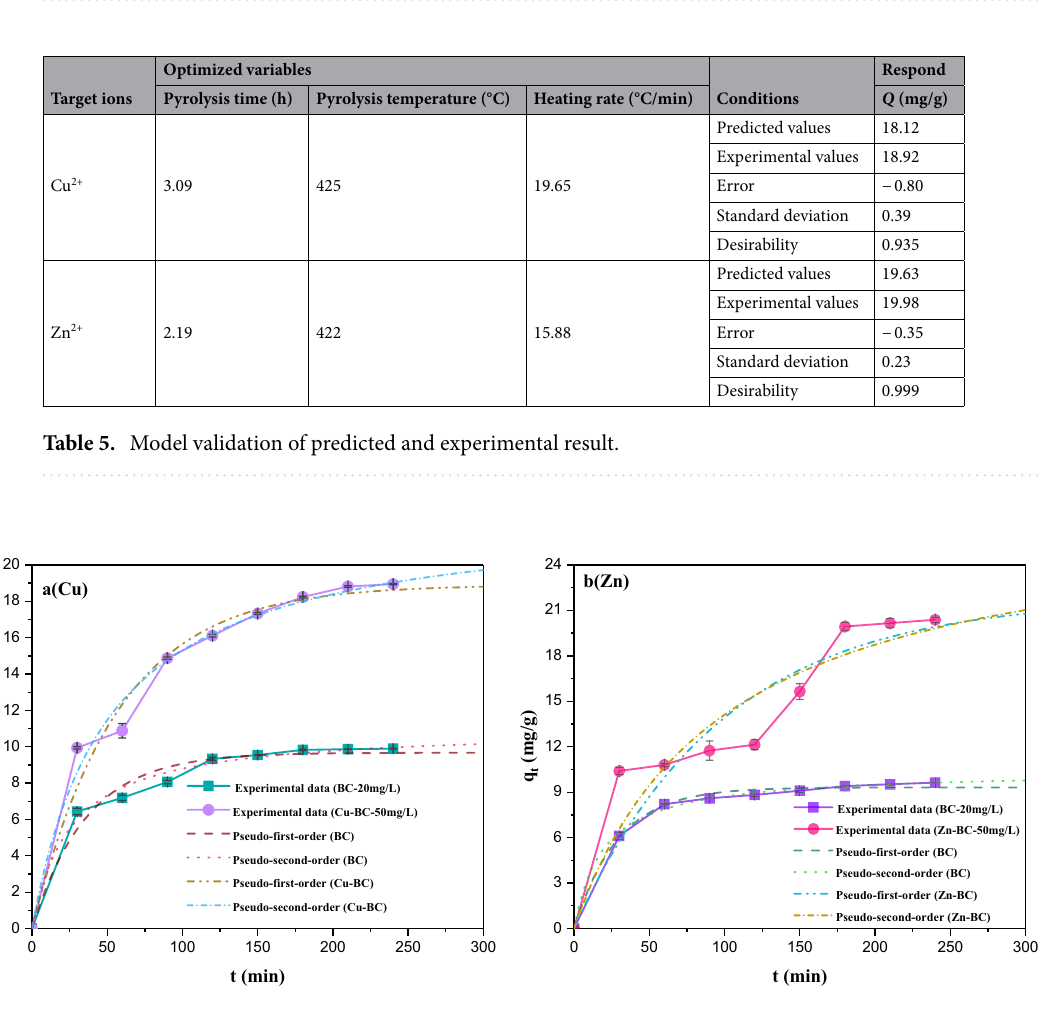
Figure 5. Adsorption kinetics curves (adsorption conditions: t = 25 °C, pH = 5.5, dosage = 2.0